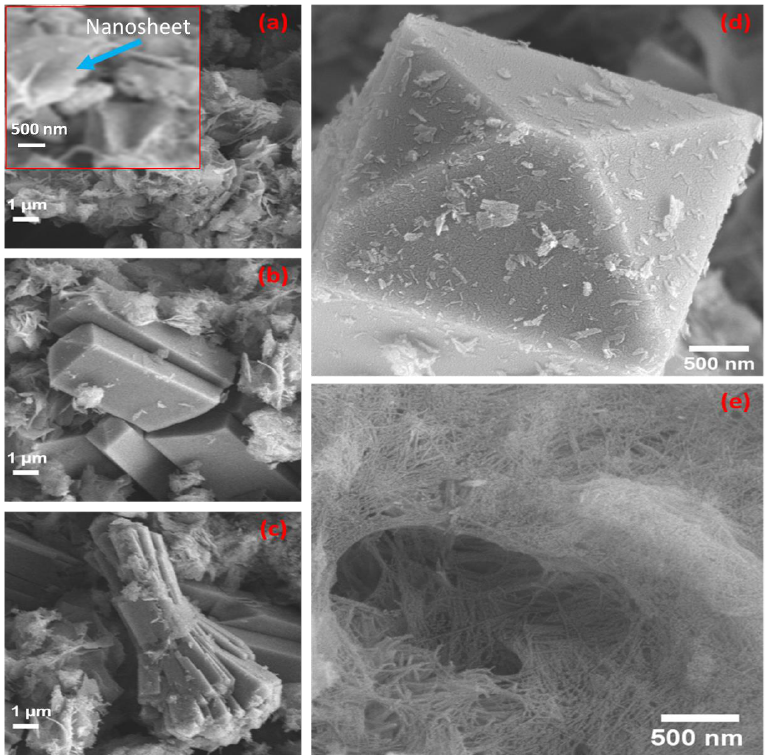
Figure 3. ( a – e ) FESEM images of a zeolite sample after undergoing hydrothermal treatment at 250 °C for 6 h showed various morphological features. The inset of ( a ) shows a magnified SEM image of the